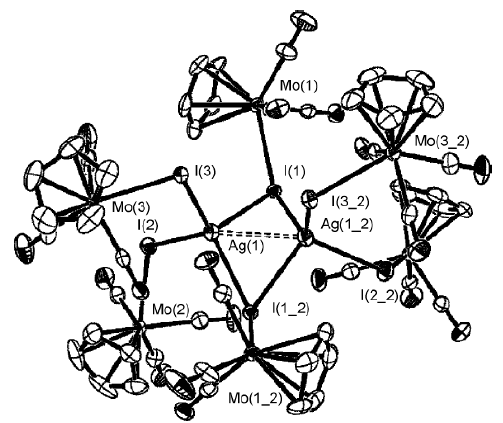
Figure 83. Structure of the{([(Cp)Mo(CO) 3 I] 3 Ag) 2 } 2+ cation in the complex {([(Cp)Mo(CO) 3 I] 3 Ag) 2 }[HCB 11 HMe 11 ] 2 . Reproduced from reference [93] with permission from The Royal Society of Chemistry. Single crystals of {(MeCN) 2 Ag[CB 11 H 12 ]} n were grown by crystallization of Ag[CB 11 H 12 ] from acetonitrile/trifluoroethanol solution. The silver atom is linearly coordinated by two crystallographically equivalent acetonitrile ligands at the Ag-N distance 2.172(5) Å and N-Ag-N angle of 157.6(2)°. There are four additional interactions to BH groups of three surrounding [CB 11 H 12 ] − anions at Ag…H-B distances 2.421 and 2.405 Å forming a distorted octahedral coordination environment (Figure 84a). Each [CB 11 H 12 ] − anion forms Ag…H-B interactions with three silver centers, and every silver atom interacts with three [CB 11 H 12 ] − anions forming a 2D network. These networks pack in the crystal lattice through interdigitation of the terminal acetonitrile ligands (Figure 84b) [105].